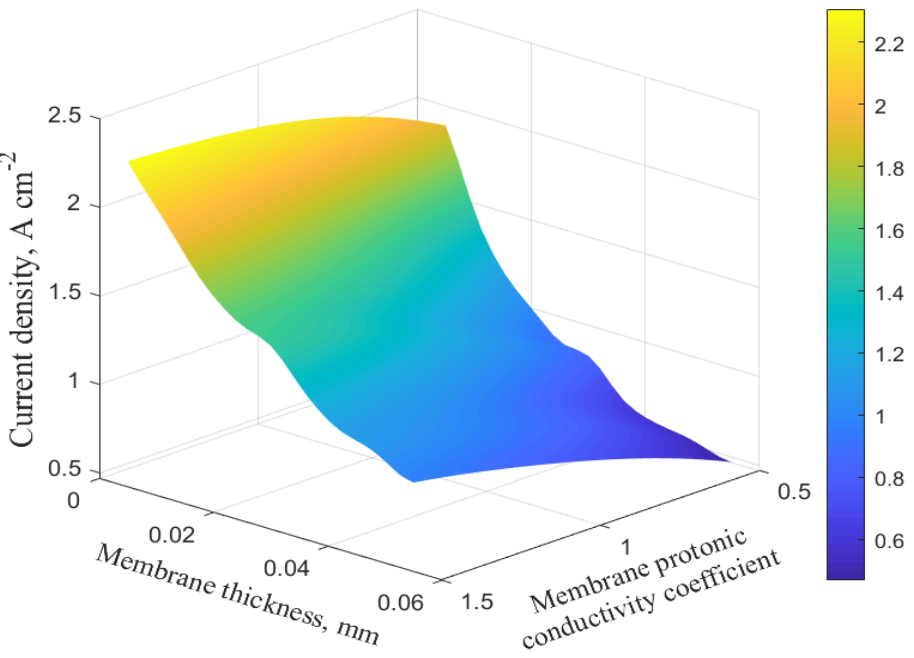
Figure 9. Three-dimensional response surface plot at 0.6 V.